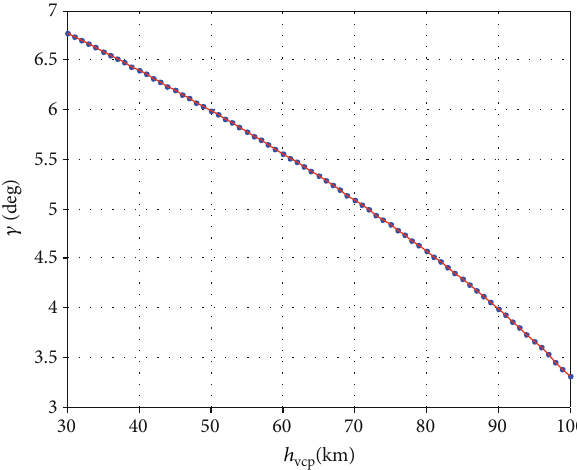
Figure 15: Relationship between VCP height and reentry